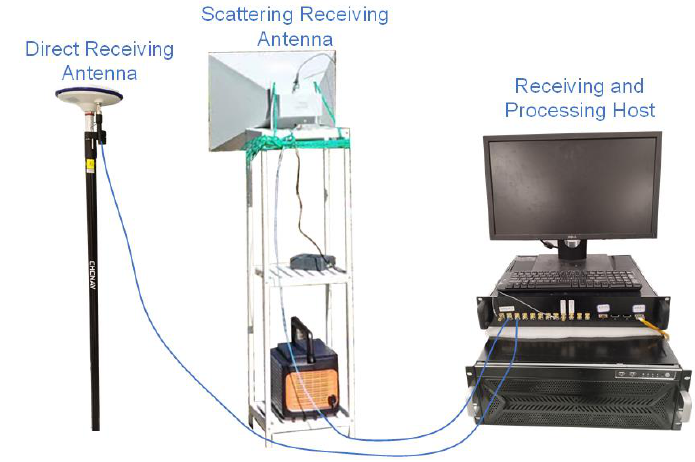
Figure 1. Composition Diagram of GNSS-S Radar System. Table 1. Main parameters of the system.